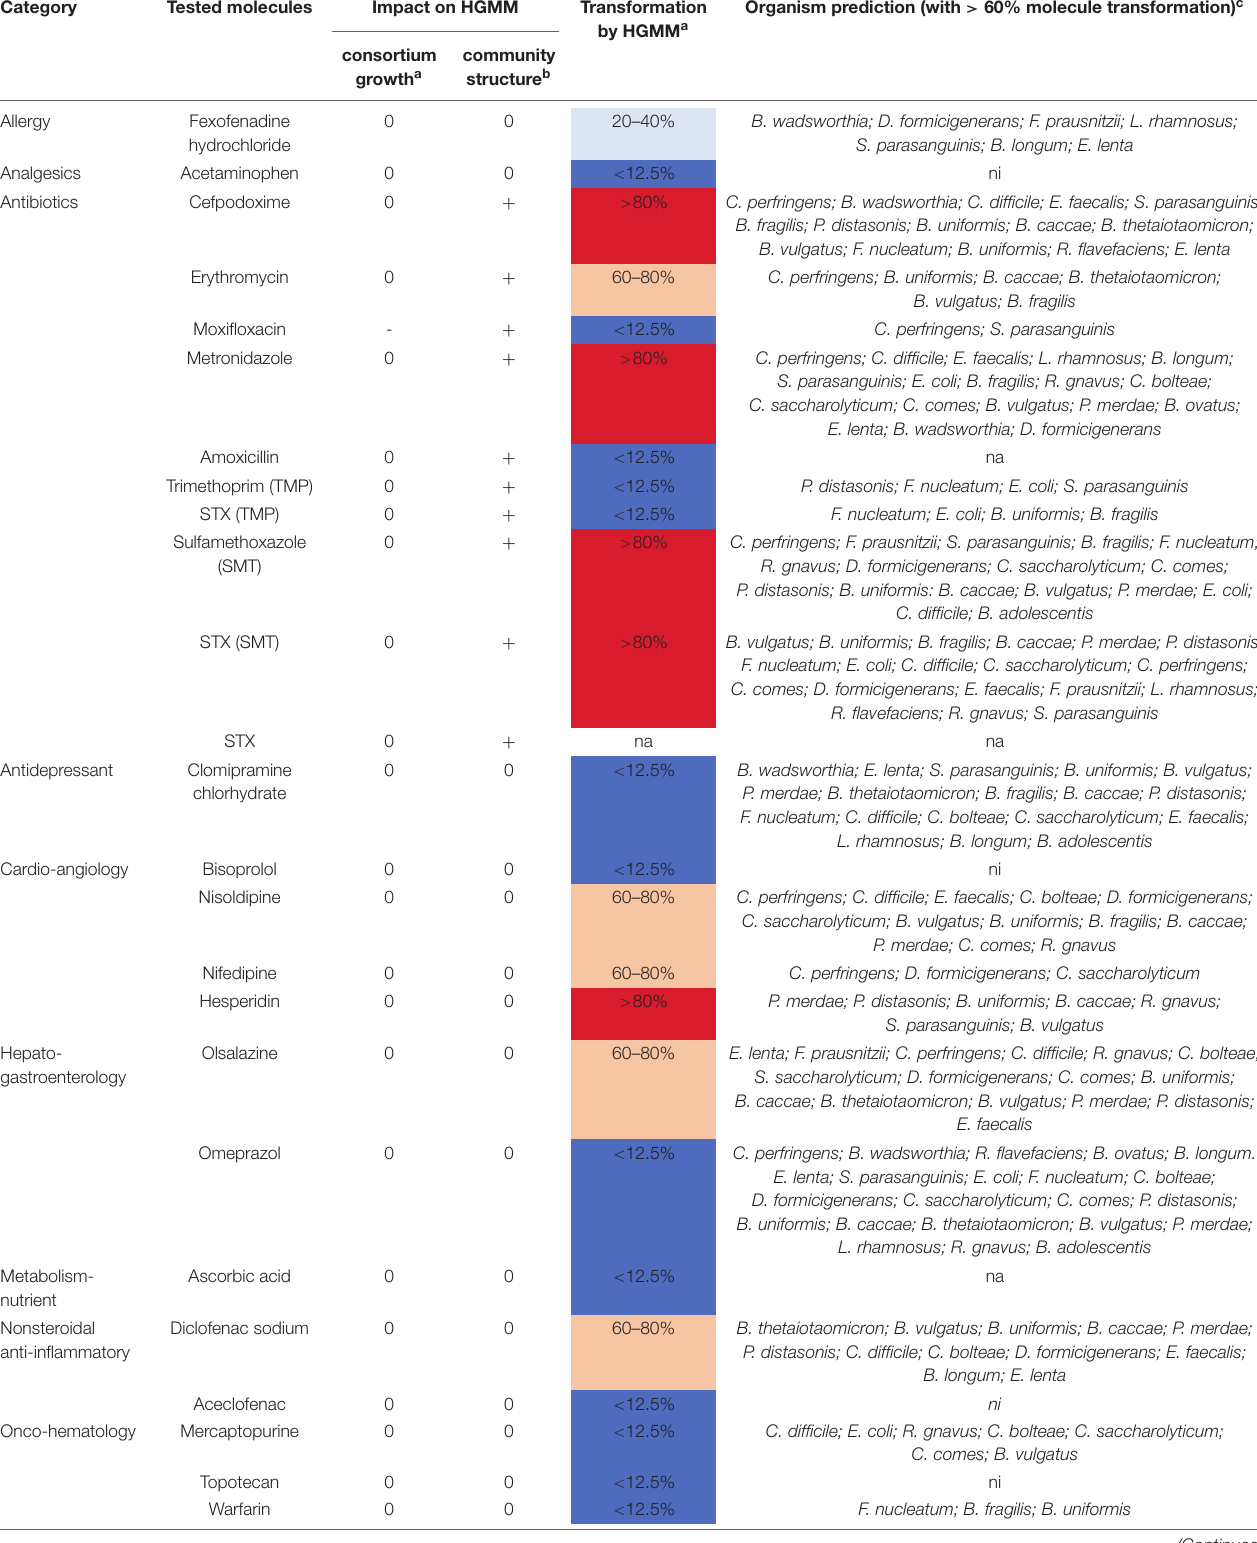
TABLE 4 | Summary of the HGMM reciprocal interactions with the 36 tested antibiotics, drugs, and xenobiotics, and prediction of bacterial species potentially implied in its transformation.